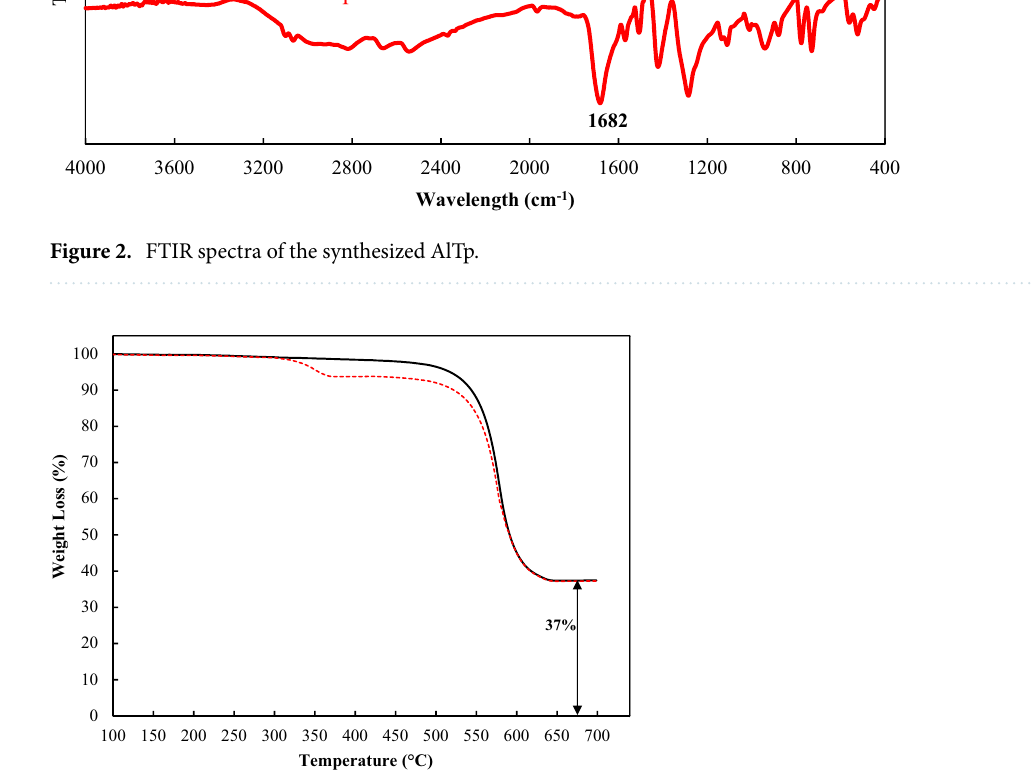
Figure 3. Thermogravimetry analysis (TGA) curve for (dashed line) [BMPyr][Cl]/AlTp and (straight line) AlTp.